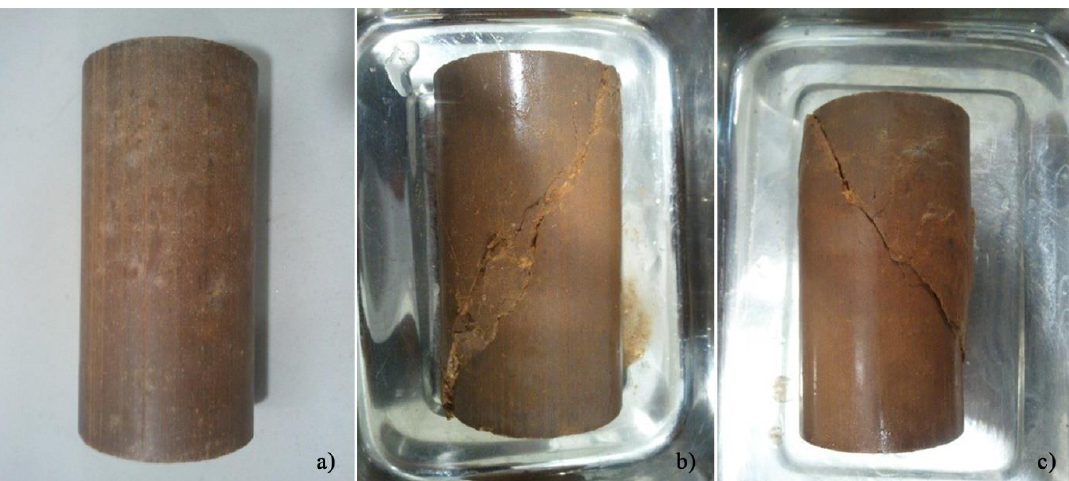
Figure 4. CIU triaxial tests performed on the OPC-S material after 90 days curing.